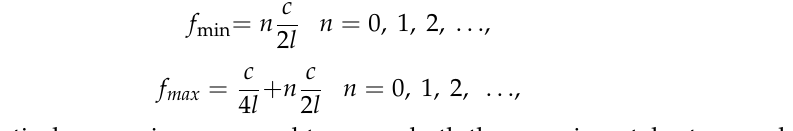
Table 1. Air and water characteristics used in the numerical model.